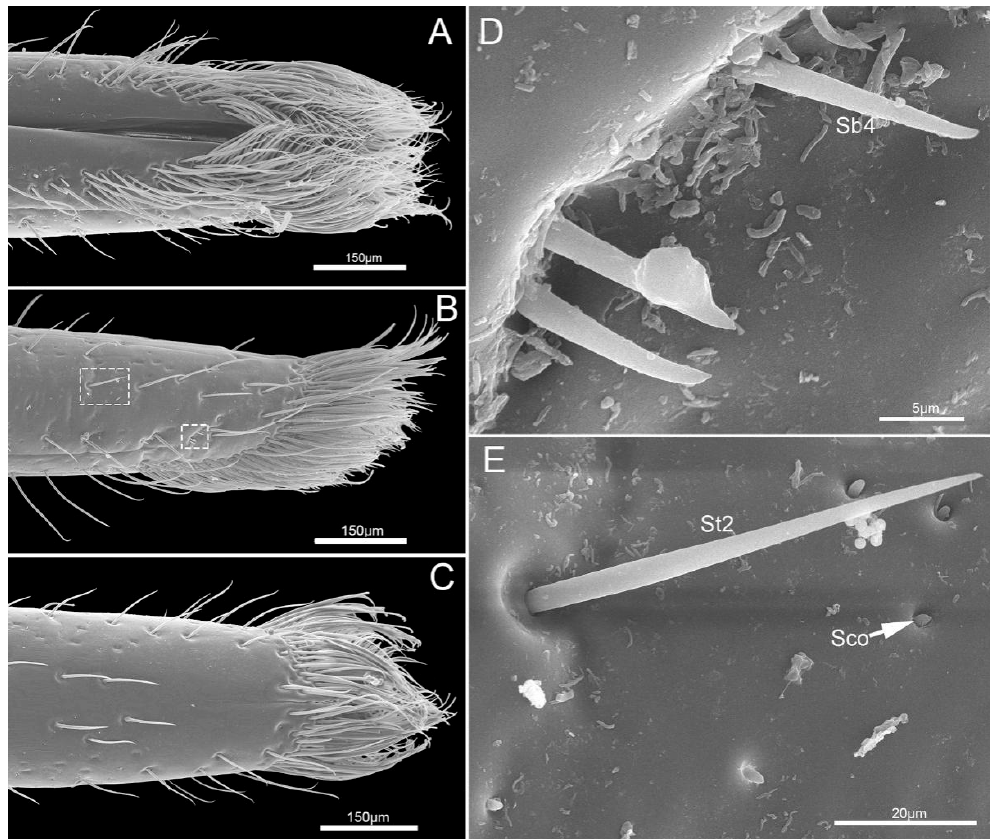
Figure 7. Proximal position the fourth labial segment of E. fullo . ( A ) Ventral view; ( B ) Lateral view; ( C ) Dorsal view; ( D ) Sensilla basiconica 4 (Sb4); ( E ) Enlarged view of outlined box of ( B ), showing sensillum trichodeum 2 (St2) and sensilla coeloconica (Sco).